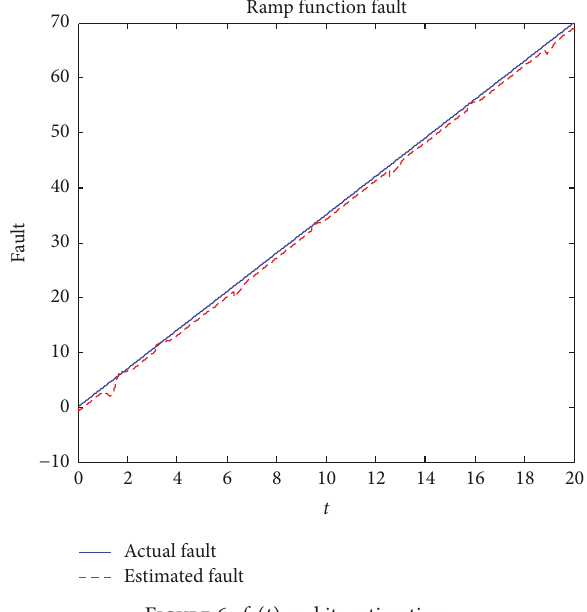
Figure 6: 𝑓 2 (𝑡) and its